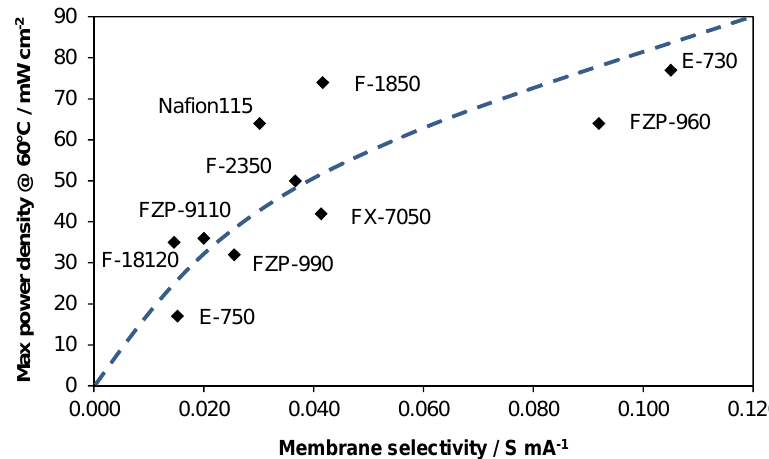
Figure 4. Performance vs. selectivity for MEAs equipped with different membranes at 60 °C (2 M